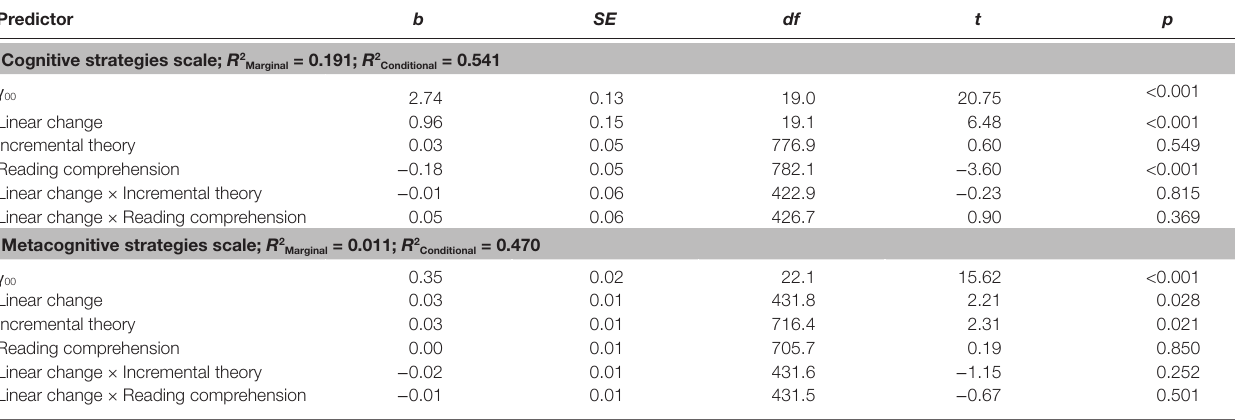
TABLE 4 | Linear mixed-effects models predicting the self-report scales for learning strategy use. Predictor b SE df t p Cognitive strategies scale; R 2 Marginal = 0.191; R 2 Conditional =